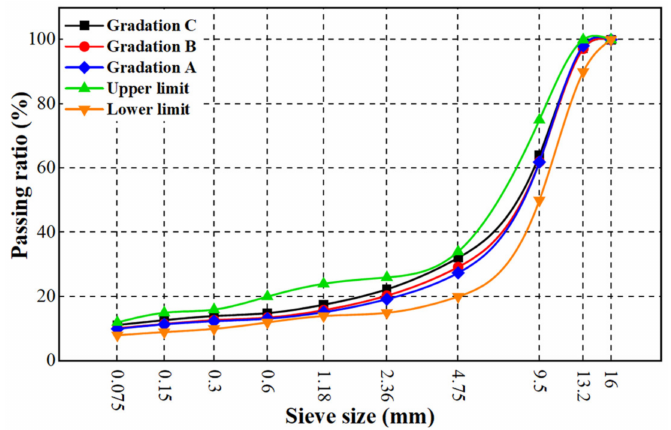
Figure 6. Grading curves of the SMA-13